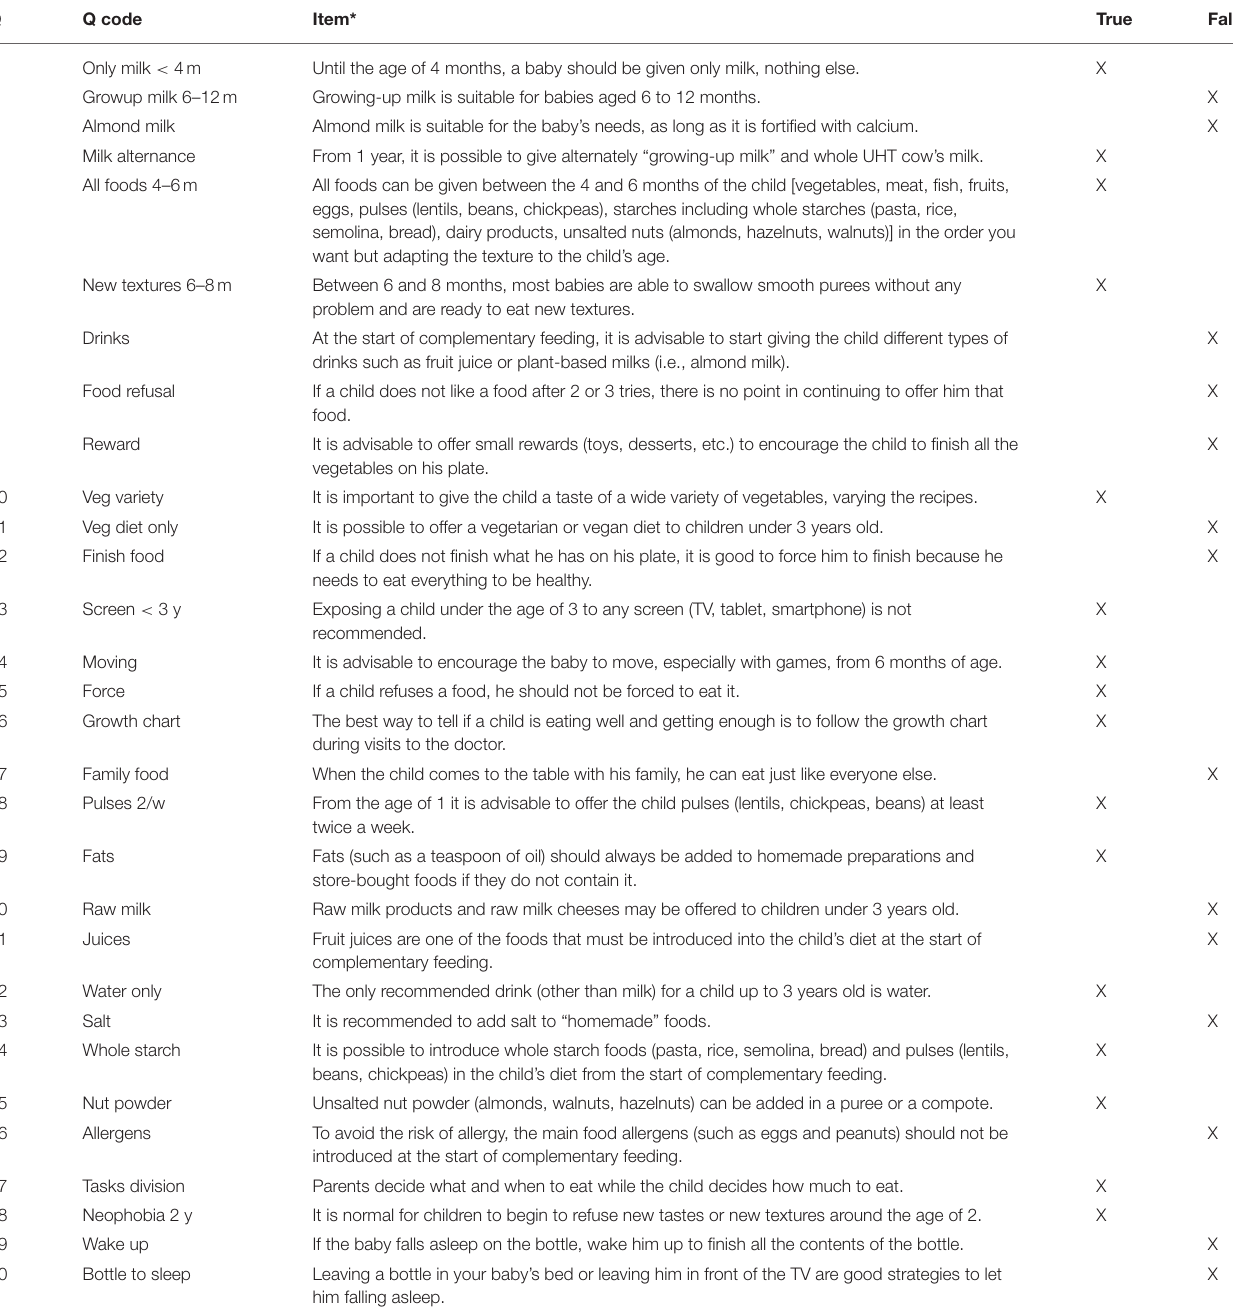
TABLE 1 | Items exploring parental knowledge about child feeding.